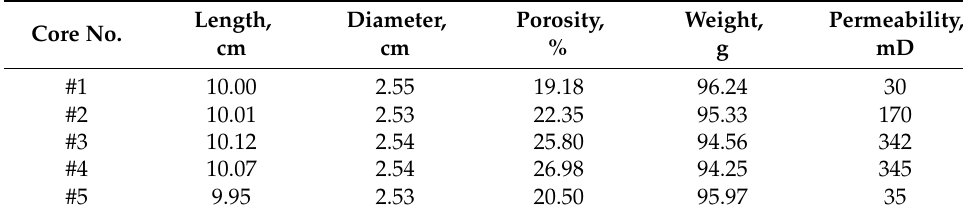
Table 2. Basic information of the core samples. Core